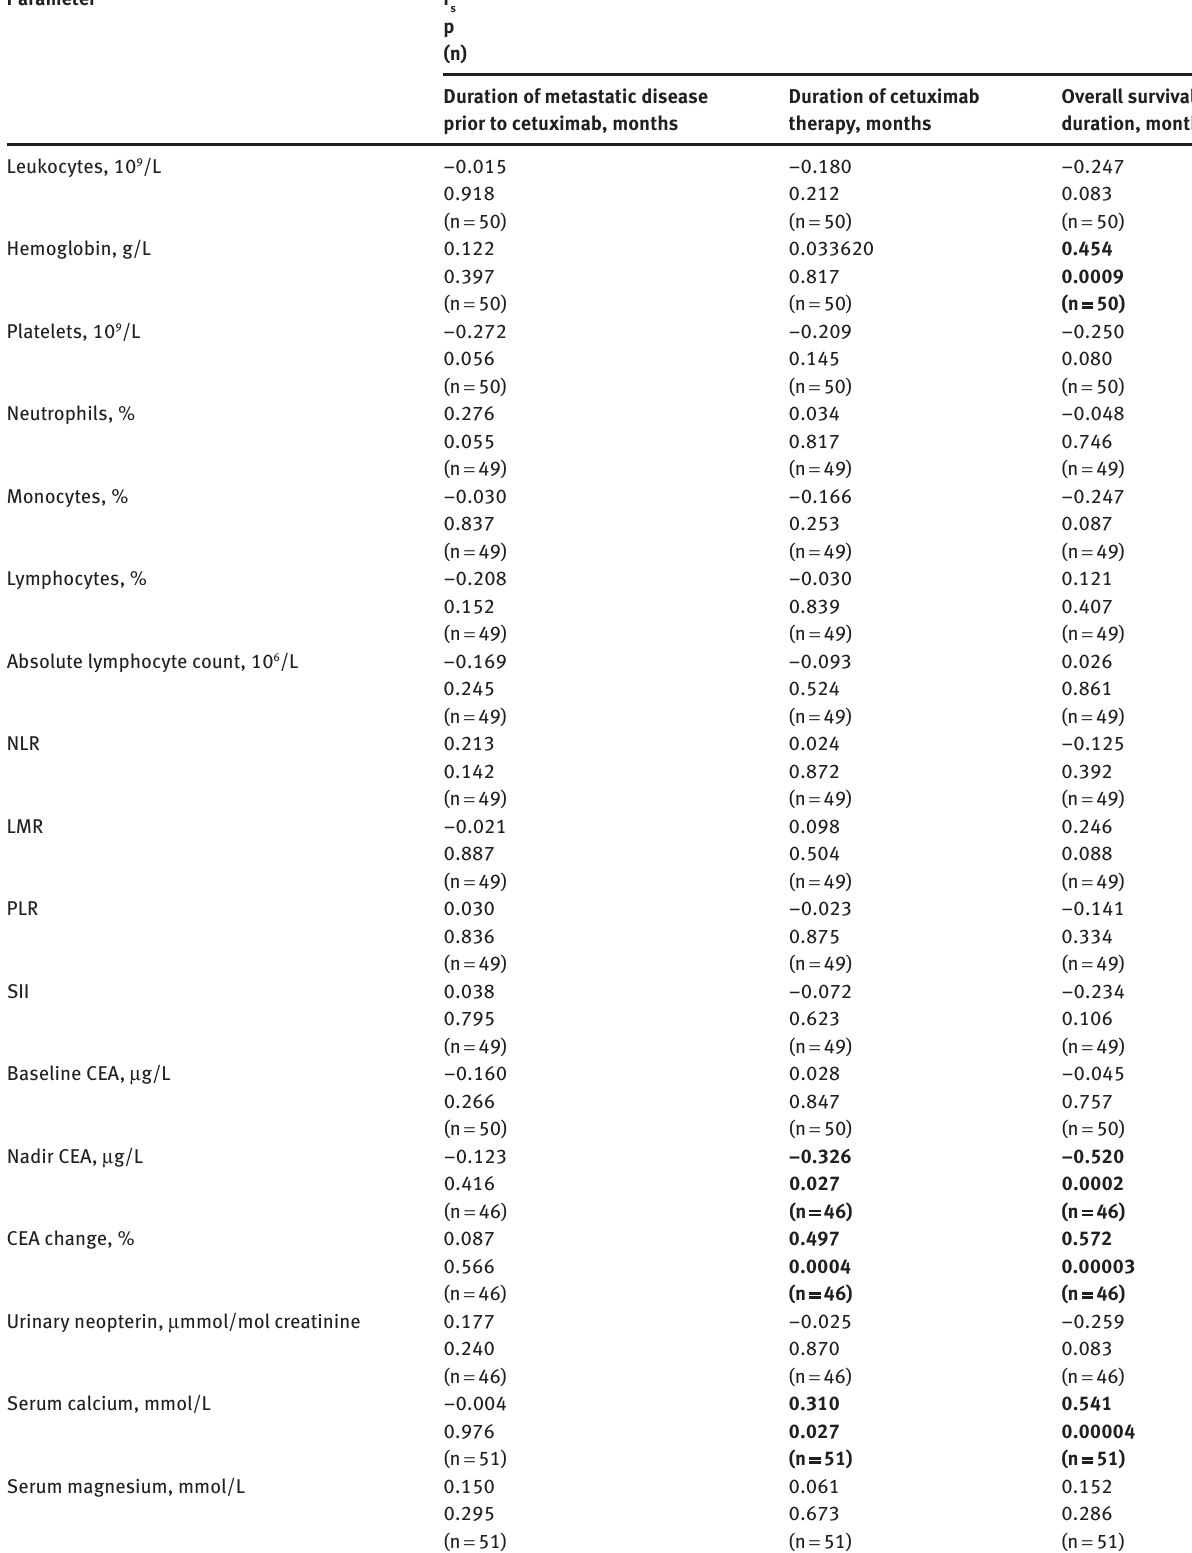
Table 3: Correlation between duration of metastatic disease prior to cetuximab therapy, duration of cetuximab therapy, overall survival duration and laboratory